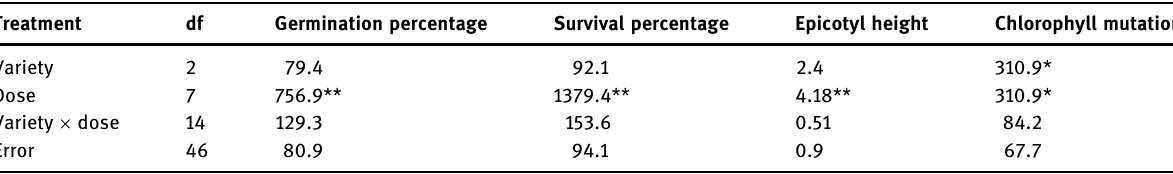
Table 1: Mean square of traits and irradiation doses evaluated Treatment